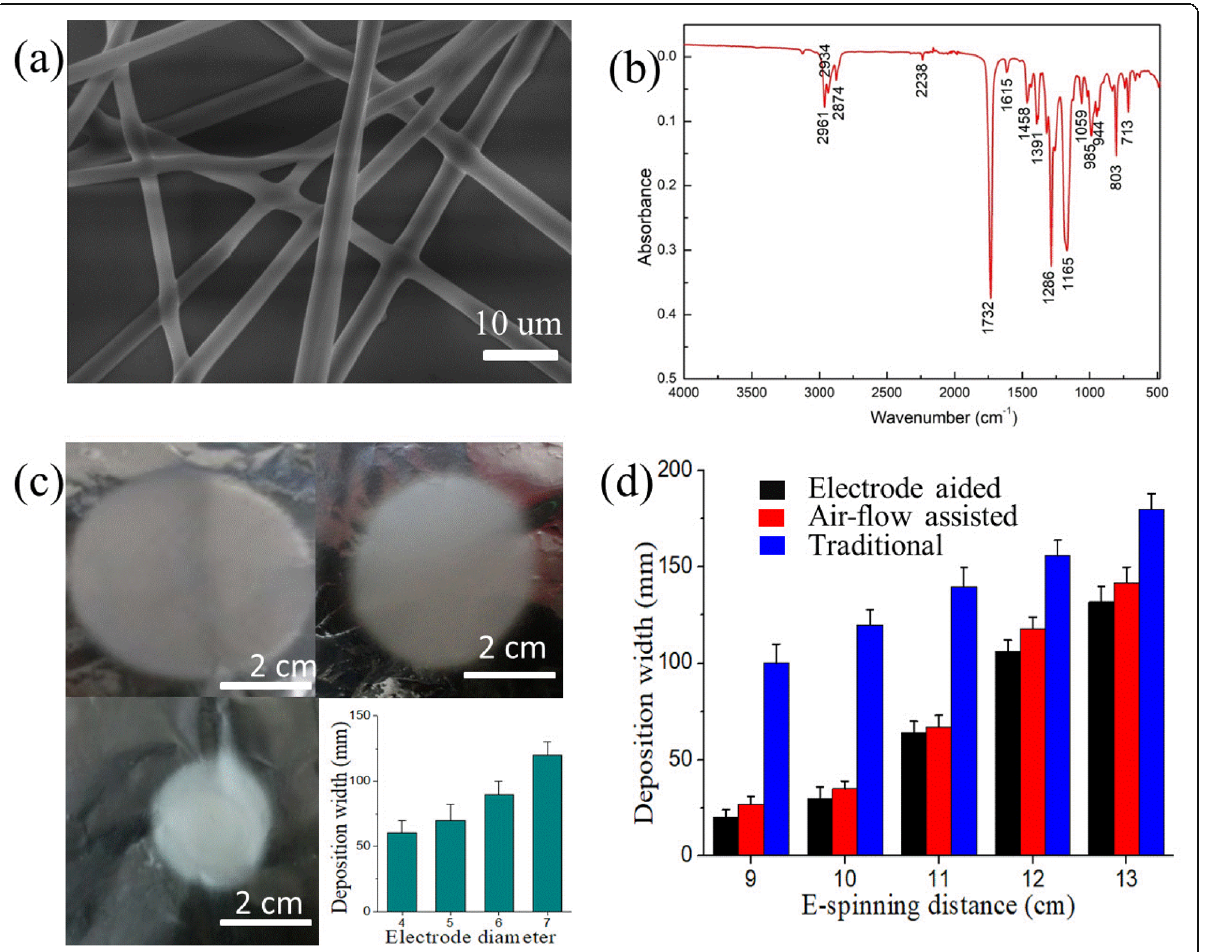
Fig. 2 a The SEM image and b FTIR spectrum of NOCA fibers obtained by the electric-field assisted e-spinning device. The size of deposition area as a function of c metallic cone diameter and d e-spinning